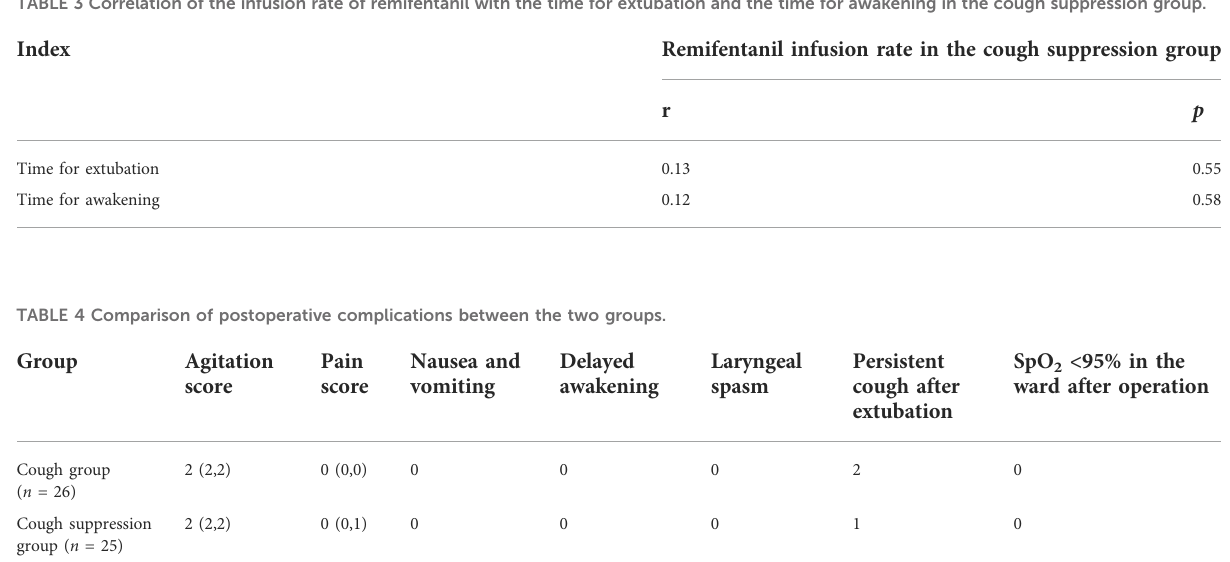
TABLE 3 Correlation of the infusion rate of remifentanil with the time for extubation and the time for awakening in the cough suppression group.